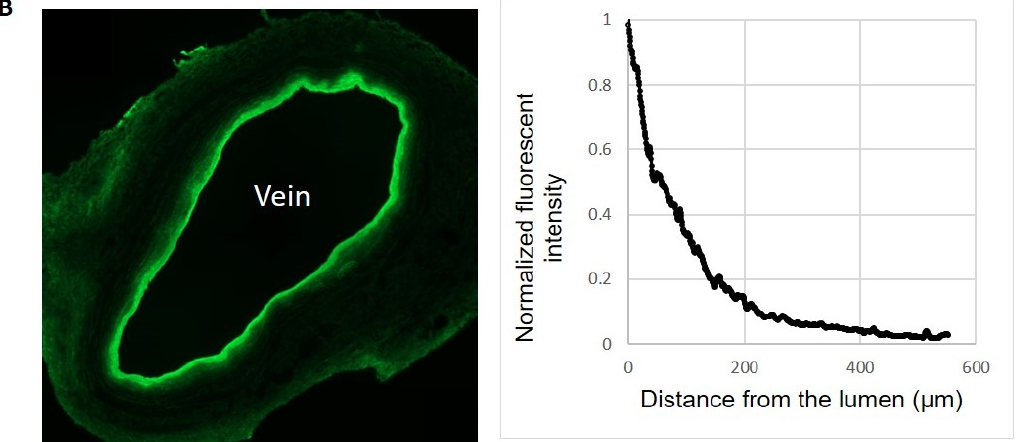
Figure 4. Human and Sheep Vein Differences. Fluorescent histological images of the cross section of sheep ( A ) and human ( B ) veins after VRS-AVF treatment. The fluorescent property of the 10-8-10 Dimer allows its detection in the vascular wall and helps monitor its distribution following treatment. The cross section of the sheep vein was taken from a freshly harvested vein immediately after VRS treatment and fistula creation surgery at the level of the anastomosis, including the feeding artery. The diagrams on the right help appreciate the significant wall thickness differences between sheep vein ( A ) and human vein ( B ) (X axis, distance from lumen/wall thickness) and the drug penetration into the wall (Y axis, fluorescent intensity normalized by the maximal intensity of each vein).